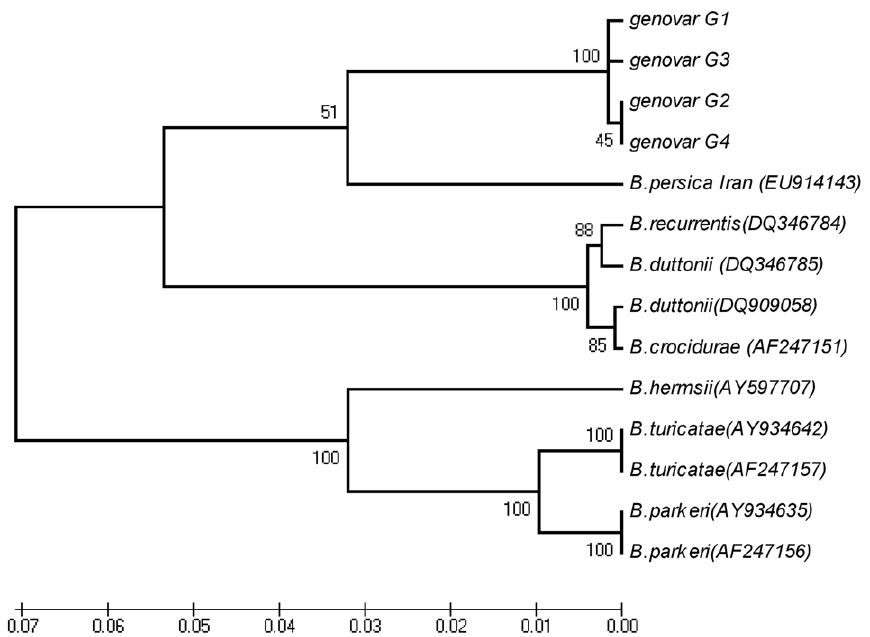
Figure 6. Phylogenic tree based on glp Q nucleotide sequences. glp Q sequences of 18 independent isolates from Israel and the West Bank belonging to genovars G1 to G4 were compared to glp Q sequences from other Borrelia species (accession numbers are given in parentheses). The isolates in each genovar are listed in Table 1. The phylogenic tree was inferred using the UPGMA method as described in Figure 2. All positions containing gaps and missing data were eliminated from the dataset (Complete deletion option). There were a total of 637 positions in the final